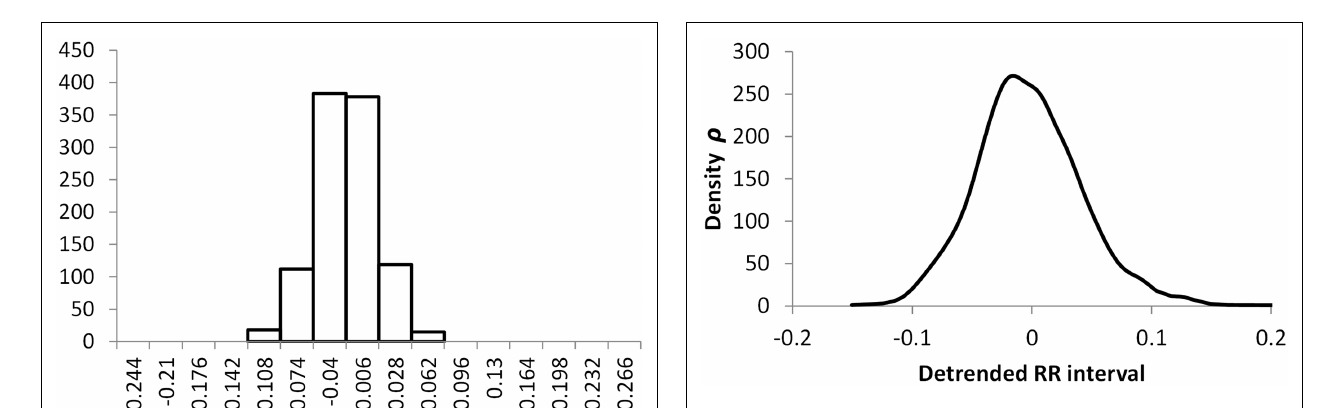
FIGURE 5 | Density of detrended RR intervals plotted against the RR interval value for participants in the Normal group .The SD is